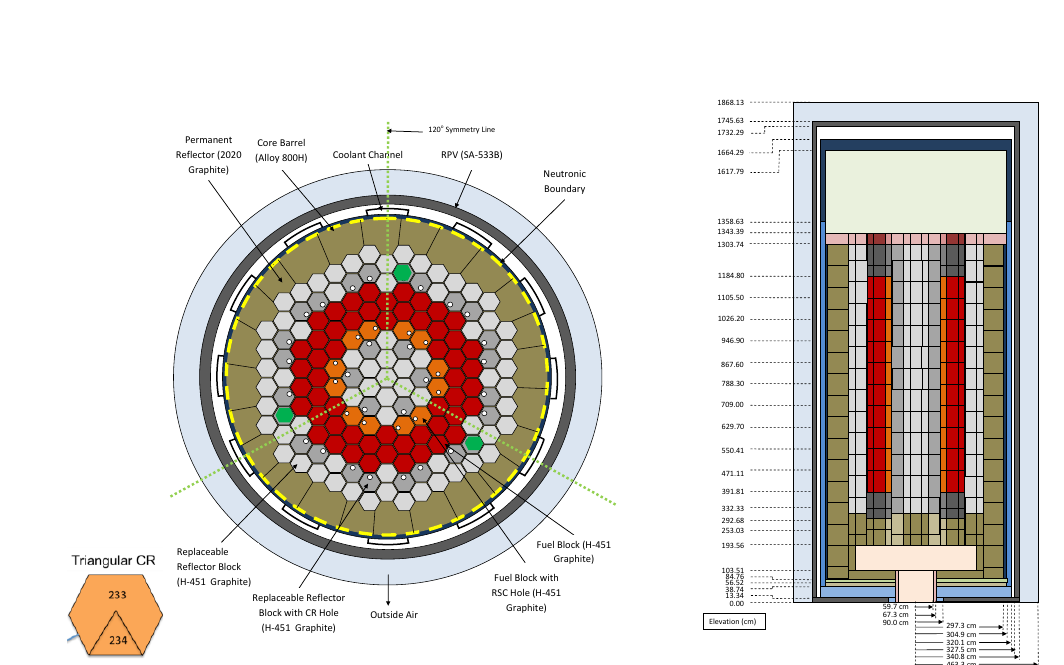
Figure 3. Radial and axial core layout of the MHTGR-350. The three positions of the partially inserted con- trol rods (hexagonal and trigonal representations shown in the lower left) are indicated by green color.